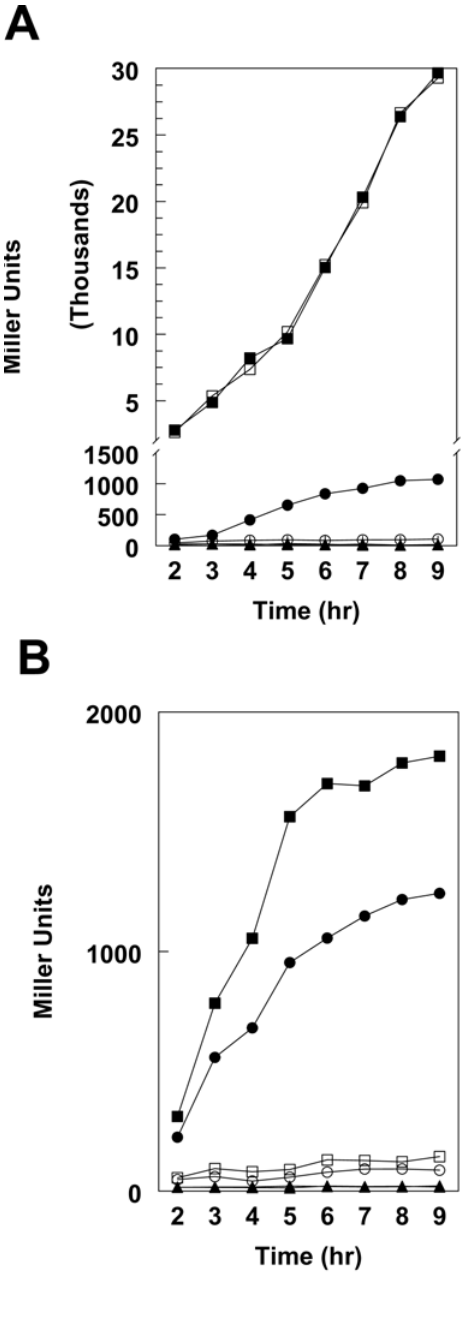
Figure 5. Toxin gene expression in B. anthracis 34F2 and 34F2 D BAS2714-12 in the presence of the carbonic anhydrase inhibitor hydrochlorothiazide. Cells carrying a pagA-lacZ fusion on the replicative vector pTCV- lac or promoter-less pTCV- lac were grown in medium supplemented with Kanamycin. b -galactosidase assays were carried out on samples taken at hourly intervals as indicated. (A) Strains grown in R Media with 0.8% NaHCO 3 under 5% CO 2 at 37 u C. (B) Strains grown in R Media without added NaHCO 3 under 5% CO 2 at 37 u C. Symbols in all panels: - & - 34F2 pagA-lacZ expression; - % - 34F2 pagA- lacZ expression with 900 m M hydrochlorothiazide; - $ - 34F2 D BAS2714- 12 pagA-lacZ expression; - # - 34F2 D BAS2714-12 pagA-lacZ expression with 900 m M hydrochlorothiazide; - m - 34F2 promoter-less pTCV- lac expression; - n - 34F2 promoter-less pTCV- lac expression with 900 m M hydrochlorothiazide.